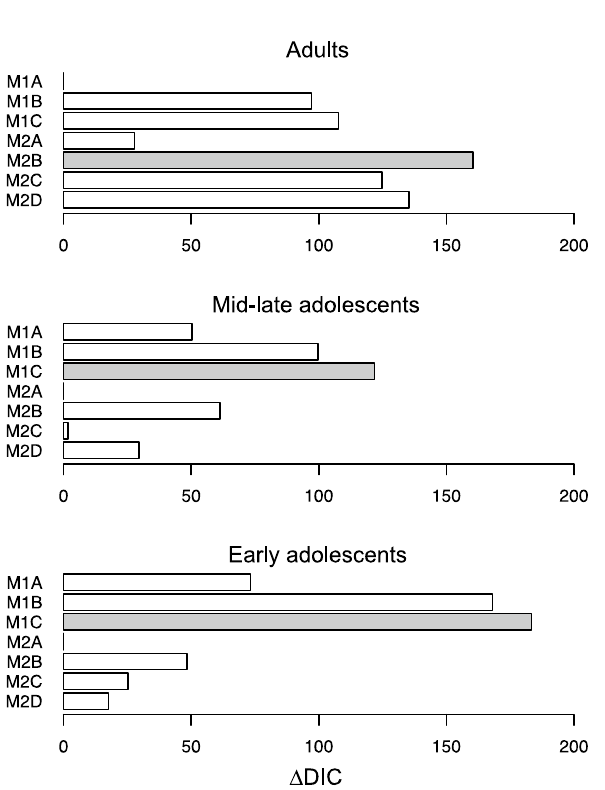
Figure 3. Model comparison. ∆DIC values reflect each model’s goodness of fit relative to the worst-fitting model. The winning model in each age group is indicated in gray. M1A = basic reinforcement-learning, M1B = reinforcement-learning with 2 learning rates, M1C = reinforcement-learning with nonlinear utility function; M2A = basic Bayesian ideal-observer, M2B = Bayesian ideal-observer with 2 update rates, M2C = Bayesian ideal-observer with nonlinear utility function, M2D = Bayesian ideal-observer with uncertainty bonus. This figure was created using RStudio 1.1.463, https:// www. rstud io.